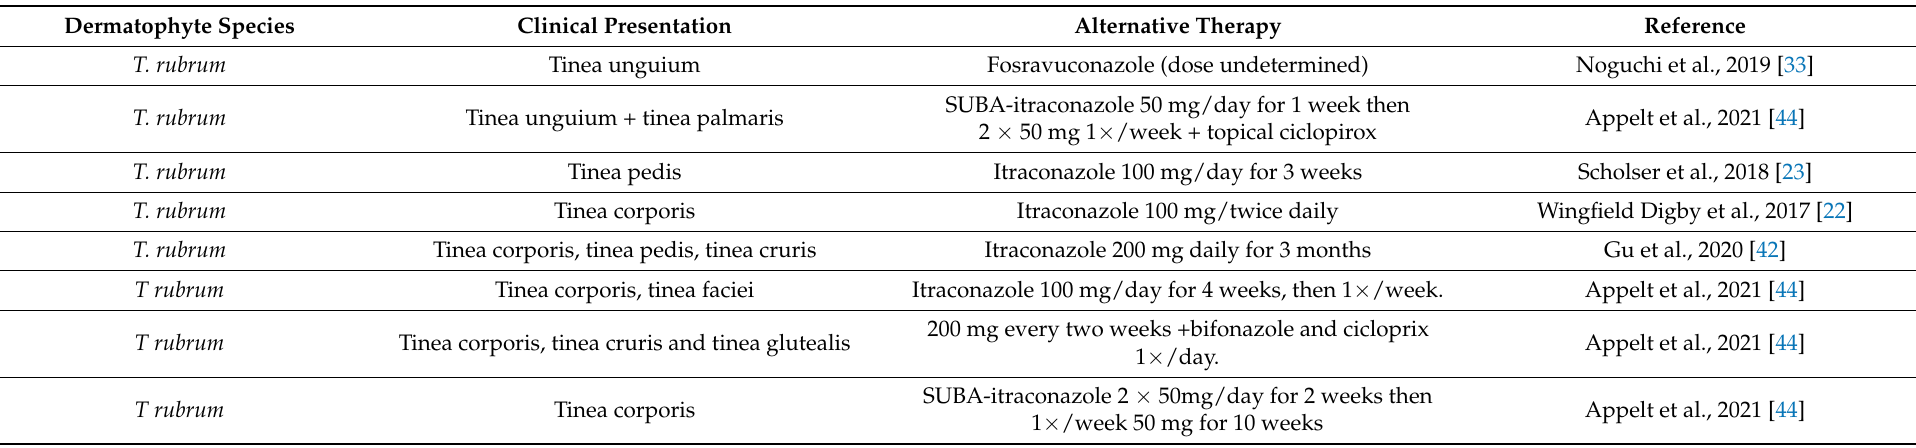
Table 2. Alternative therapies following clinical presentations for terbinafine resistant T. rubrum .